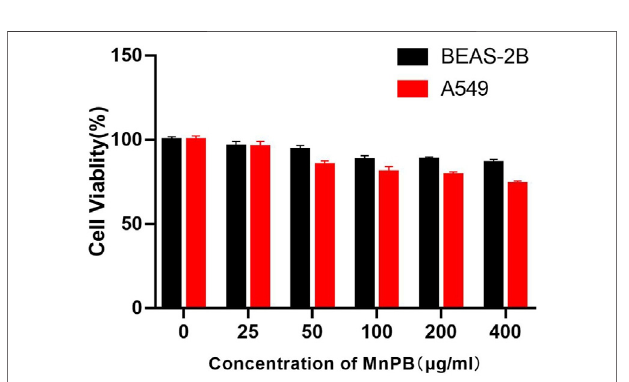
FIGURE 3 | Cytotoxicity of MnPB NPs in A549 cells and BEAS-2B cells.